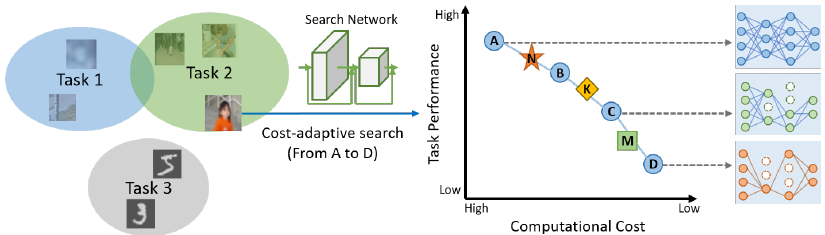
Figure 1. A graphical illustration for a cost-adaptive search of the proposed approach on three tasks (classification datasets). For each instance of a task, ours method discovers a set of different models (represented by blue circles from A to D shown to the right of the figure) trading off between task performance and computational cost in the presented search network, whereas existing model search approaches can find only a single model (represented by either N, K, or M).